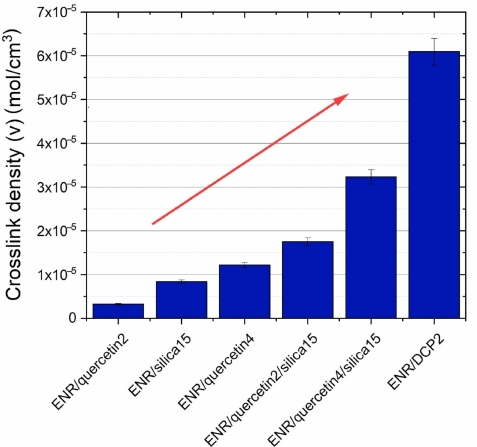
Figure 3. Crosslink density of partially cured ENR-50-based